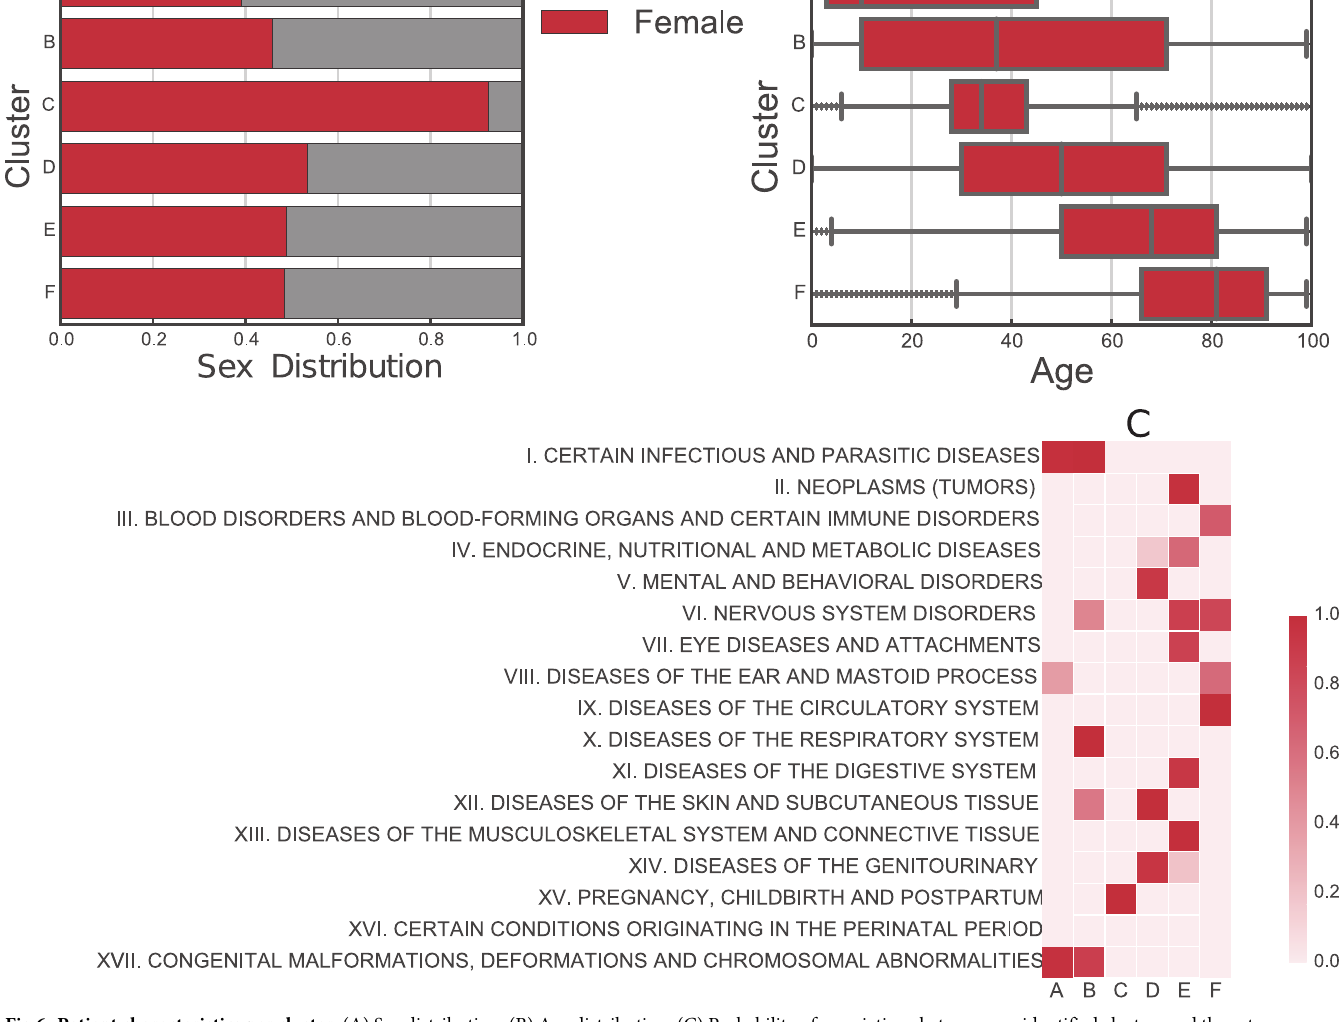
Fig 6. Patient characteristics per cluster. (A) Sex distribution. (B) Age distribution. (C) Probability of associations between our identified clusters and the category chapters of ICD10 codes (1 − ( p - value)). The alphabet letters correspond to the clusters discussed in Fig 4.